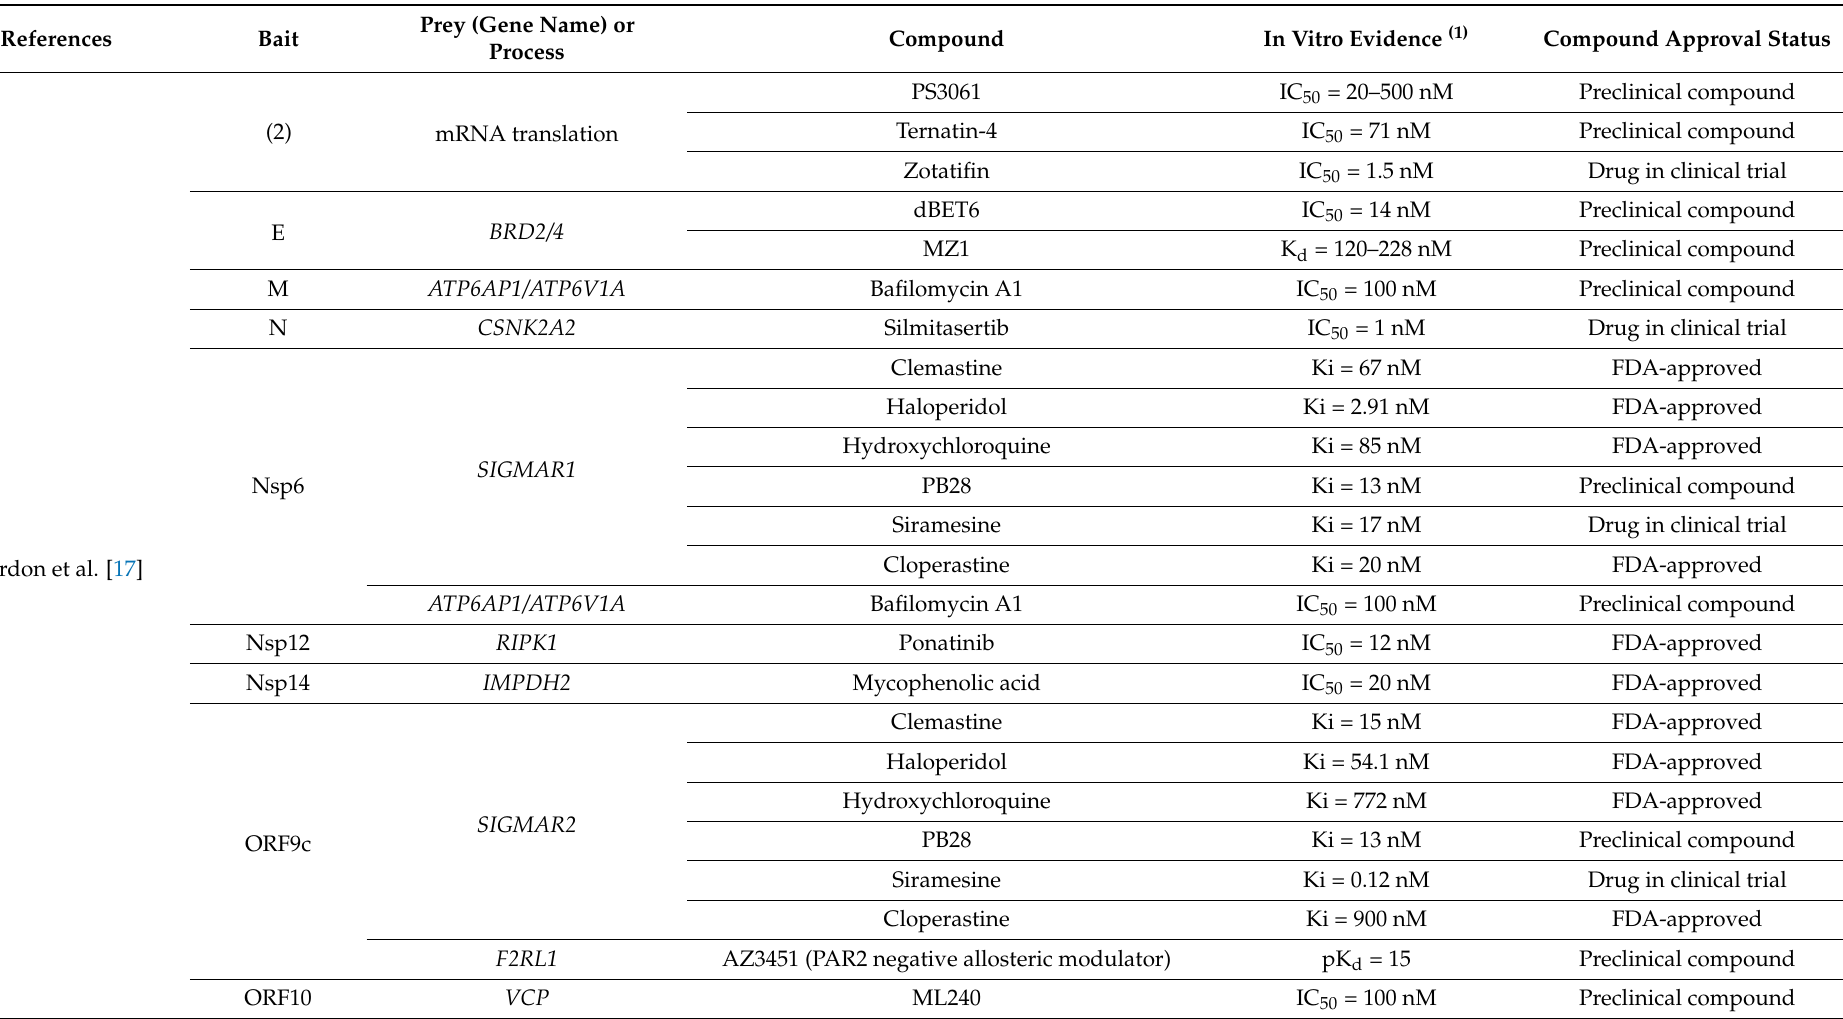
Table 2. List of PPIs-identified main candidates for repurposing drugs to treat COVID-19